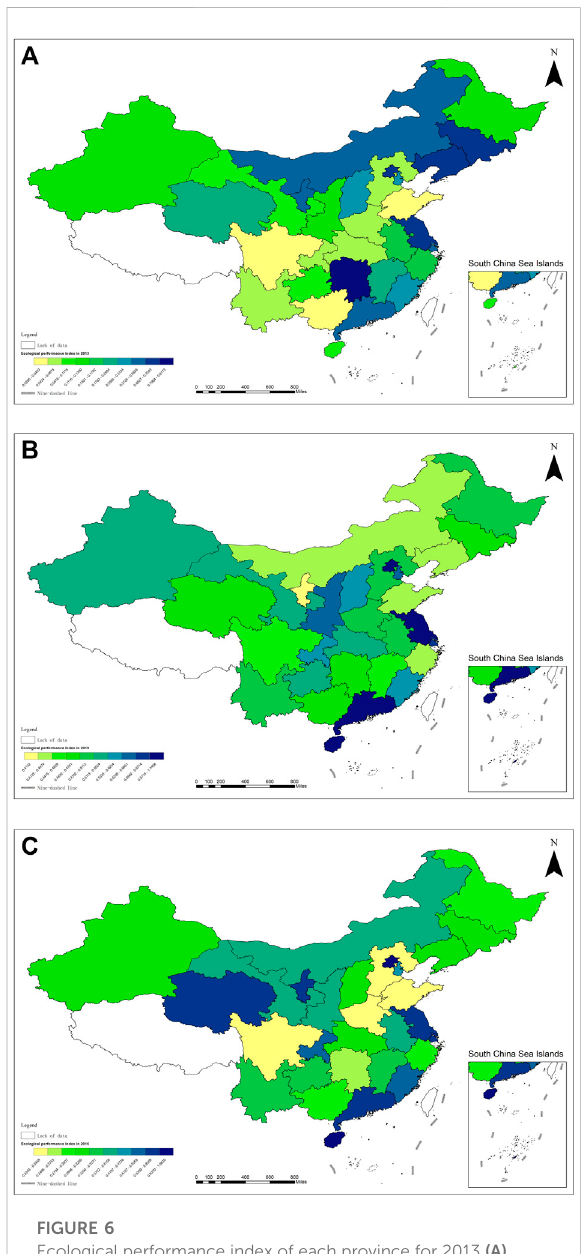
FIGURE 6 Ecological performance index of each province for 2013 (A) , 2016 (B) , and 2019 (C)